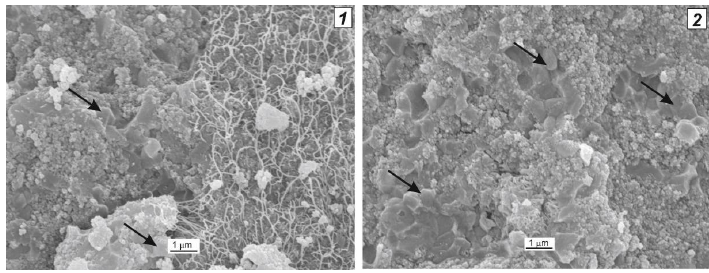
Figure 4. SEM images of cleavages of the whole-cell biocatalysts prepared by immuring r E. coli /xyl cells inside SiO 2 -xerogel with included CNTs ( 1 ) and CNFs ( 2 ). Arrows indicate entrapped bacteria.